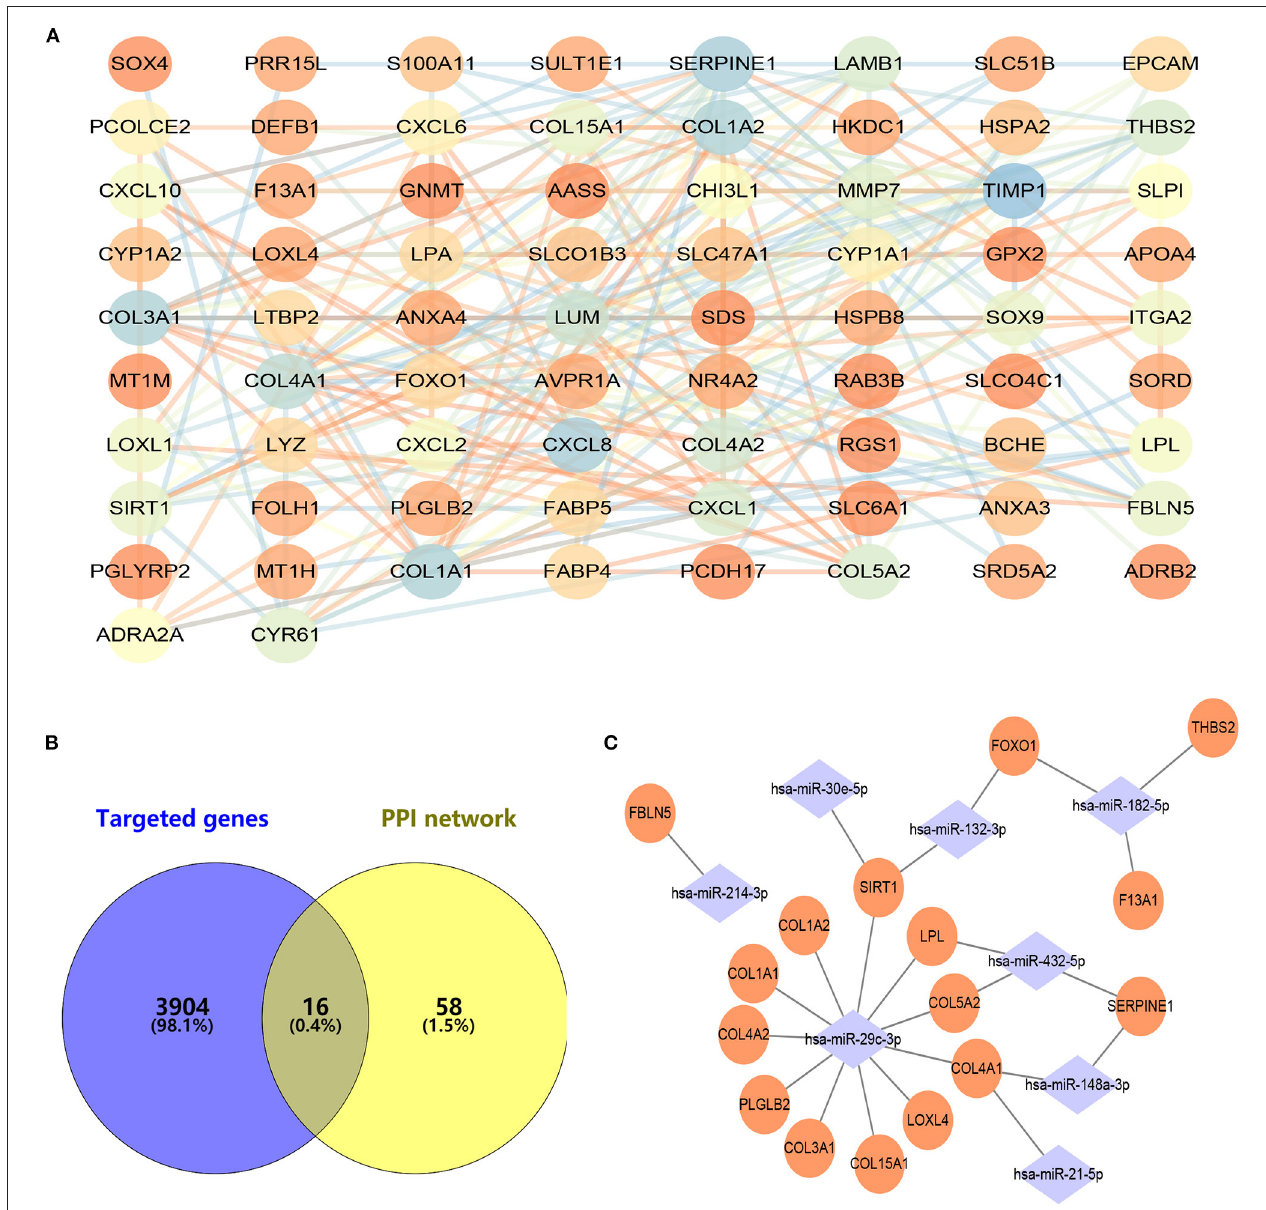
FIGURE 3 | Construction of protein–protein interaction and miRNA–mRNA networks. (A) Protein–protein interaction of CEGs with 74 nodes and 207 edges, (B) exploration of hub mRNAs in ALD development, (C) establishment of an miRNA–mRNA network by using 16 hub genes and eight miRNAs. CEGs, common differentially expressed genes; ALD, alcoholic liver disease; PPI, protein–protein interaction.